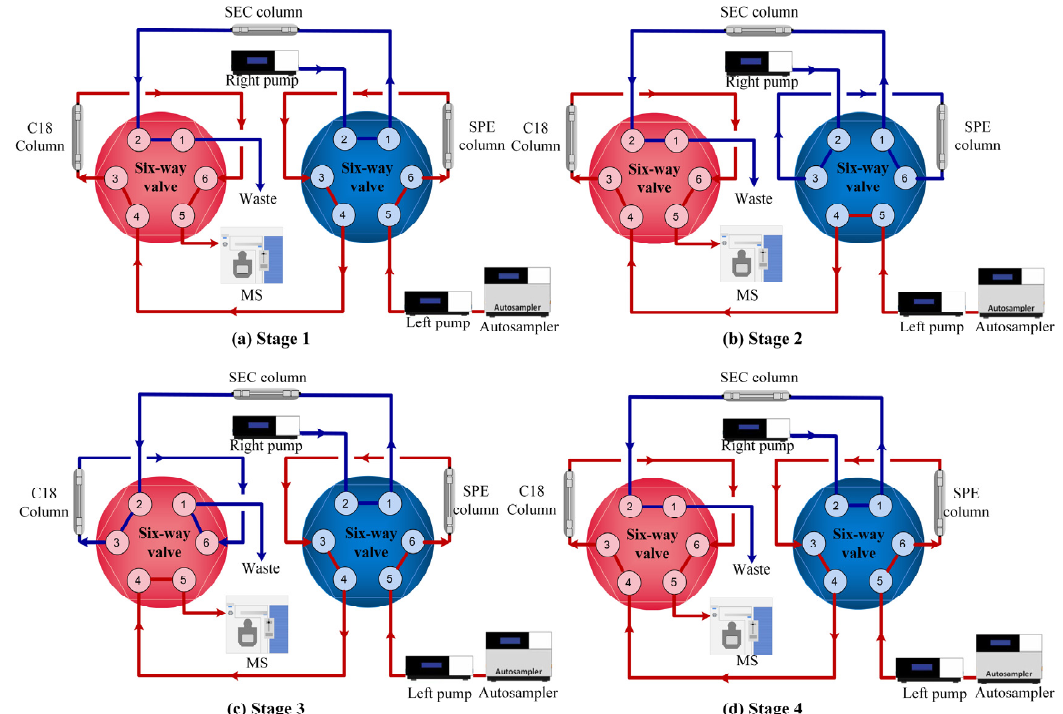
Figure 1. Scheme of the online SPE/SEC/LCMS system with four stages.